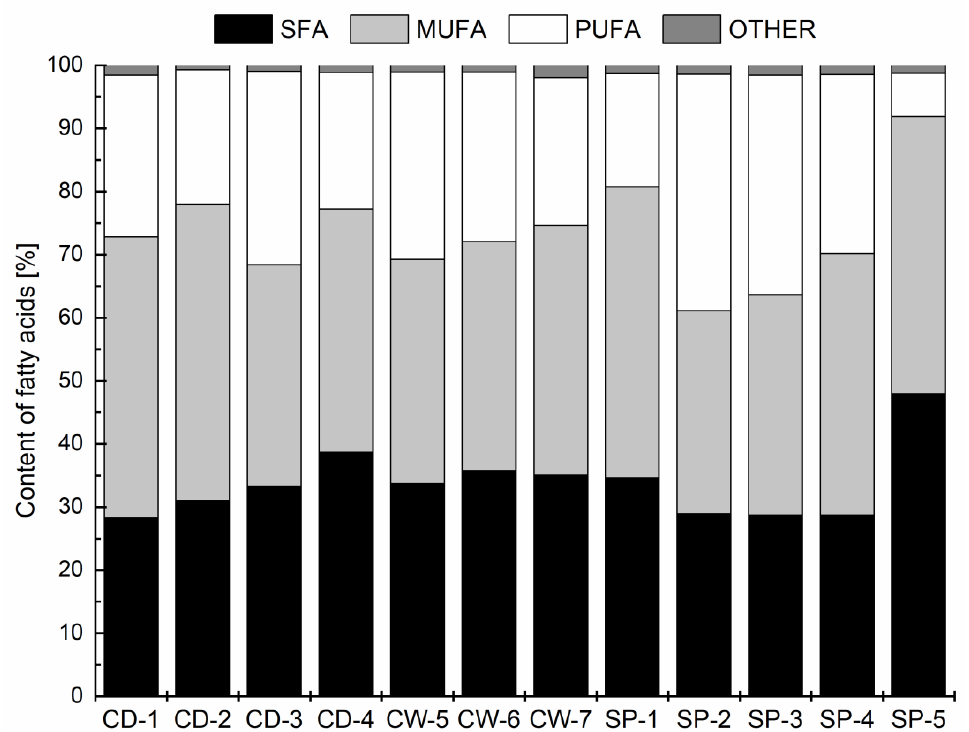
Figure 1. The content of saturated (SFA), monounsaturated (MUFA) and polyunsaturated fatty acids (PUFA) for fats extracted from commercial wet (CW), dry (CD) and self-prepared (SP) cat foods.